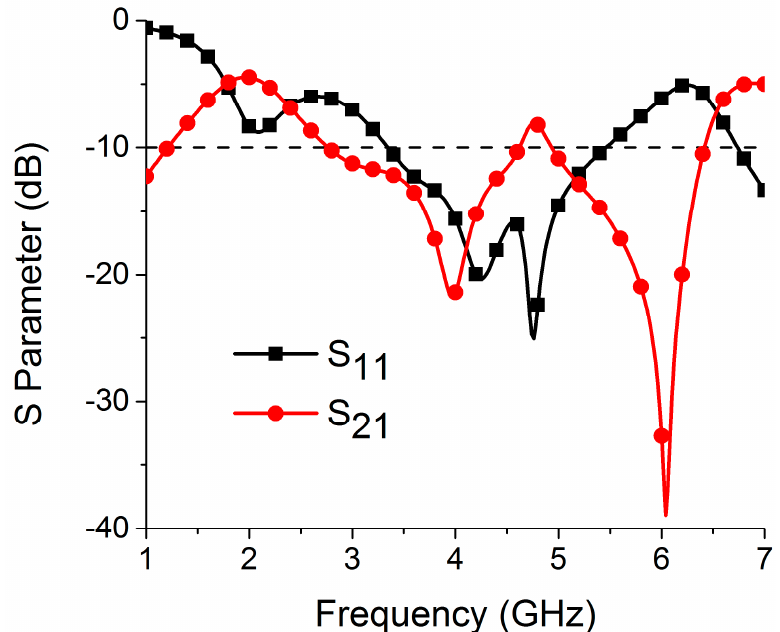
Figure 5. MIMO antenna S-parameters with two elements.